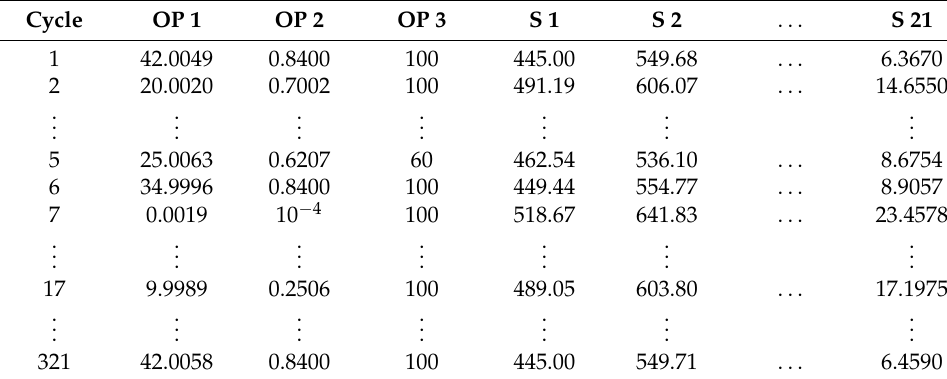
Table 2. Brief description of one life cycle data of simulation